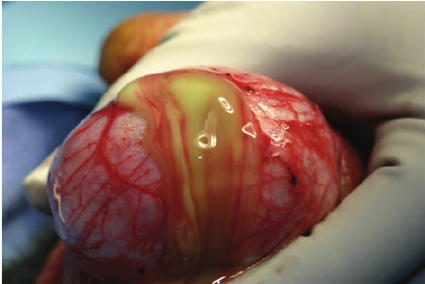
Figure 2: Intraoperative photo demonstrating extravasation of purulent fluid from left testicle.